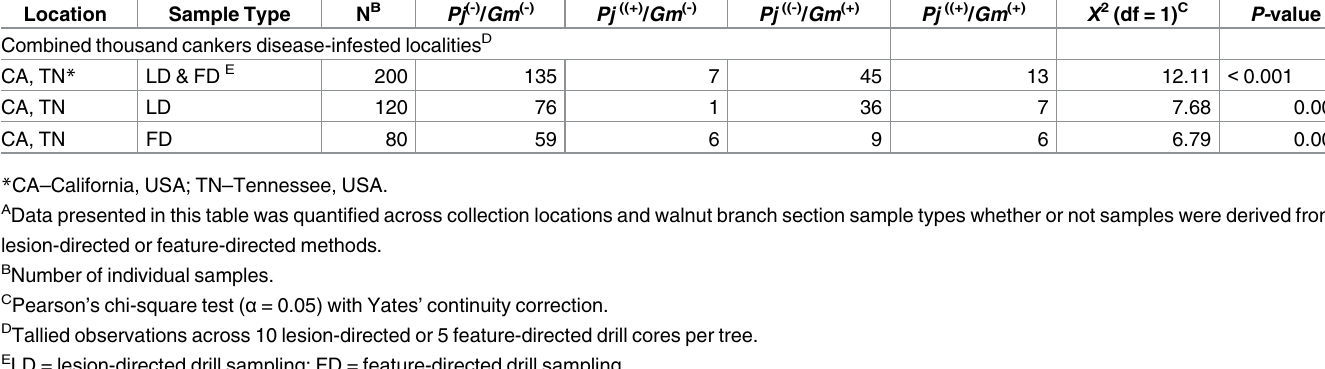
(Table 1). Effect of location was also assessed for both drilling methods (Table 1). When Cali-